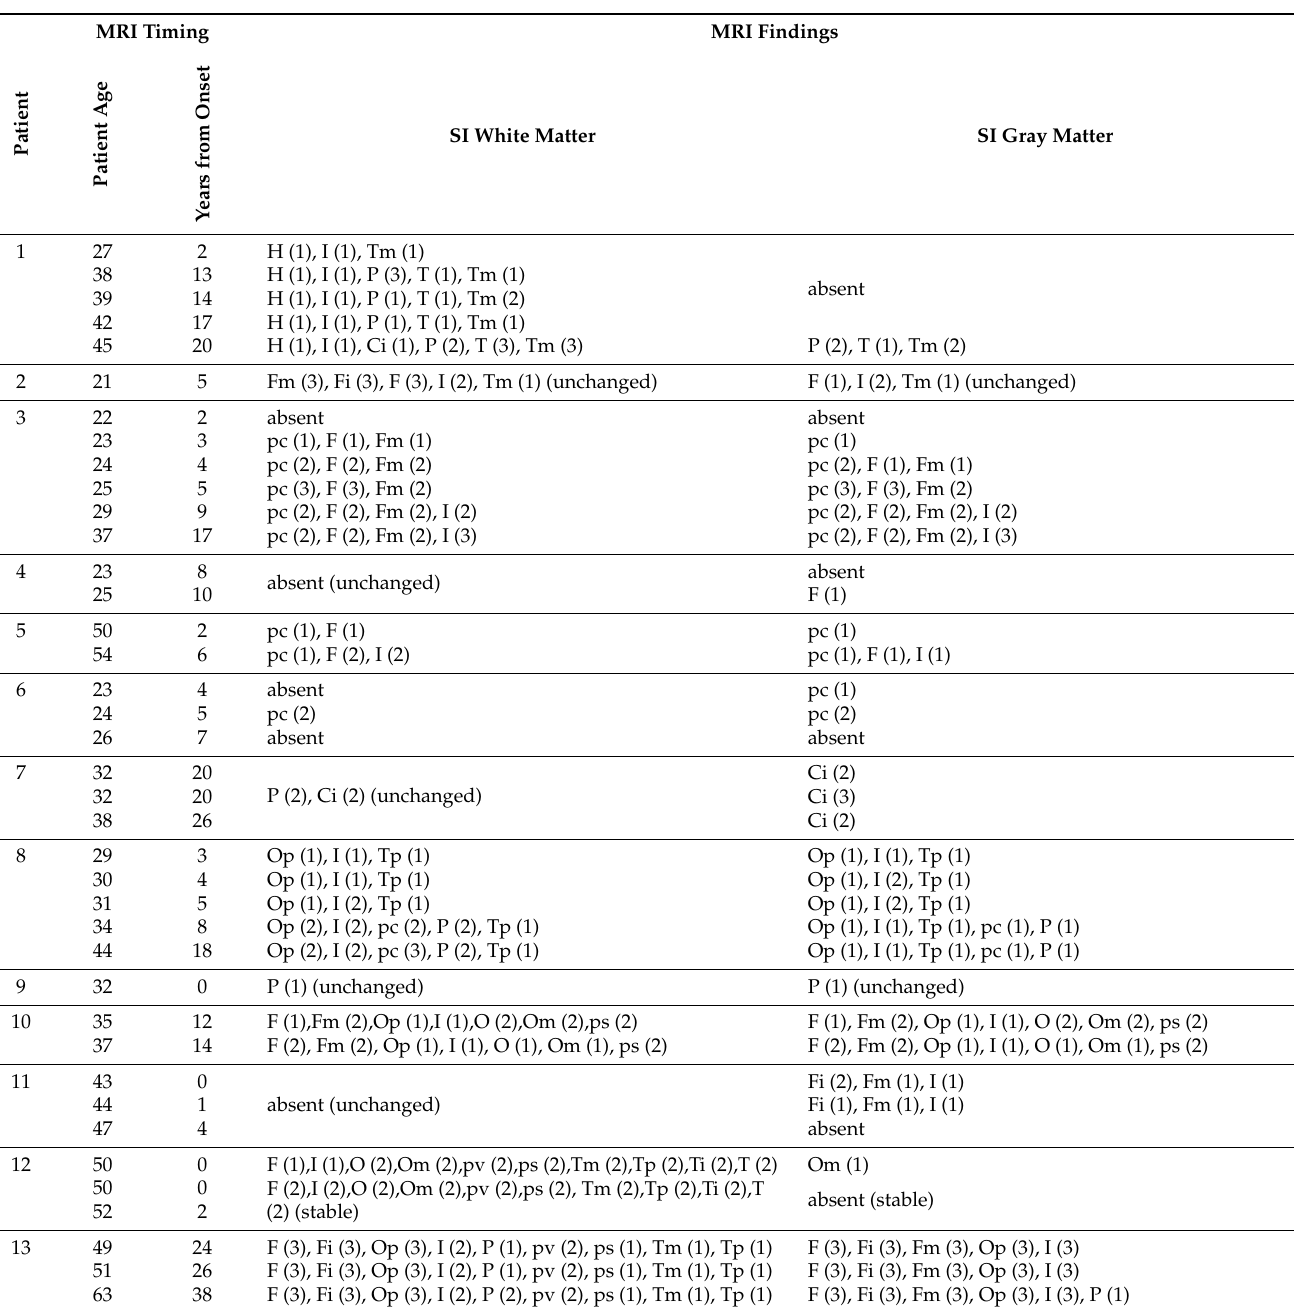
Table 3. Signal intensity changes in the white and in the grey matter of 13 patients with Rasmussen encephalitis. Each row represents radiological findings when any change occurred (either in atrophy or in signal intensity); first and last MR exam details are always reported. Abbreviations are the same as reported in Table